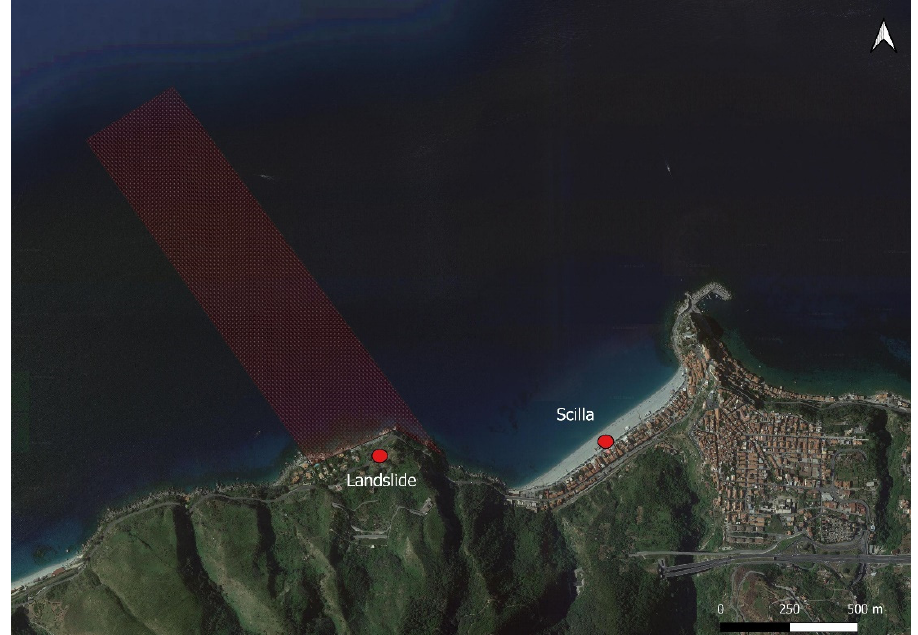
Figure 11. Identification of the subdomain affected by the landslide in QGIS (red dashed rectangle).